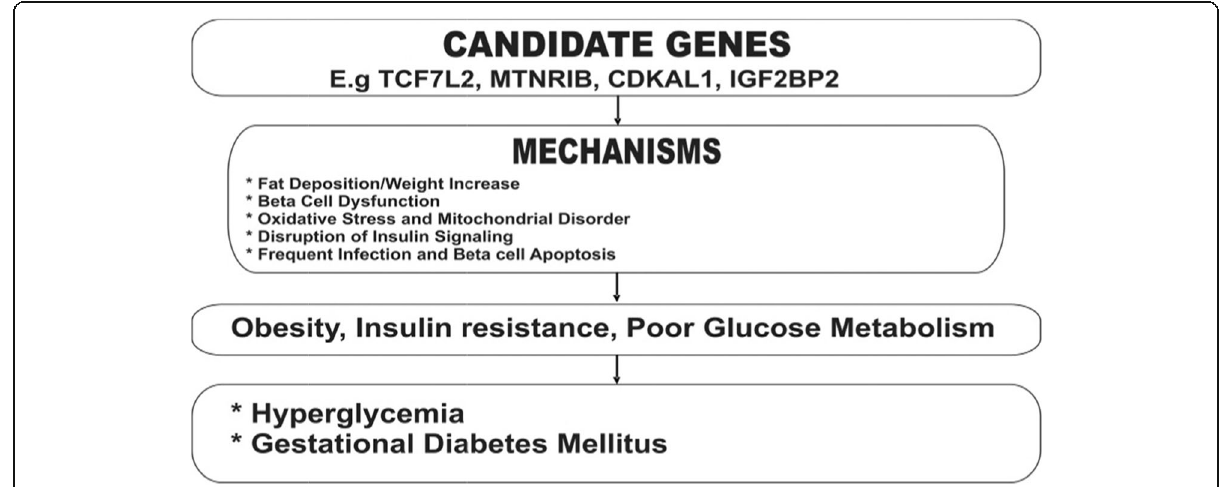
Fig. 1 Genetic etiology of gestational diabetes